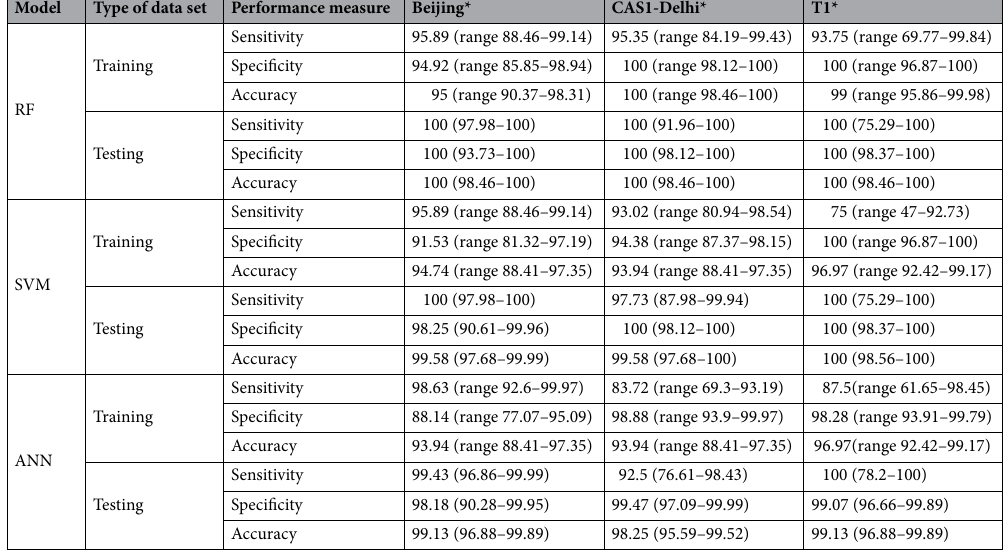
Table 8. Showing performance measure, i.e. (accuracy, sensitivity and specificity) of random forest (RF)/ support vector machine (SVM)/artificial neural network (ANN) analysis based on external database validation. The training data set is based on MTBC isolates from Sikkim and testing data set is based on MTBC isolates from a different geographical area (the state of Assam), which was not used for model training. *The values are in % and 95% confidence intervals are given in parenthesis for